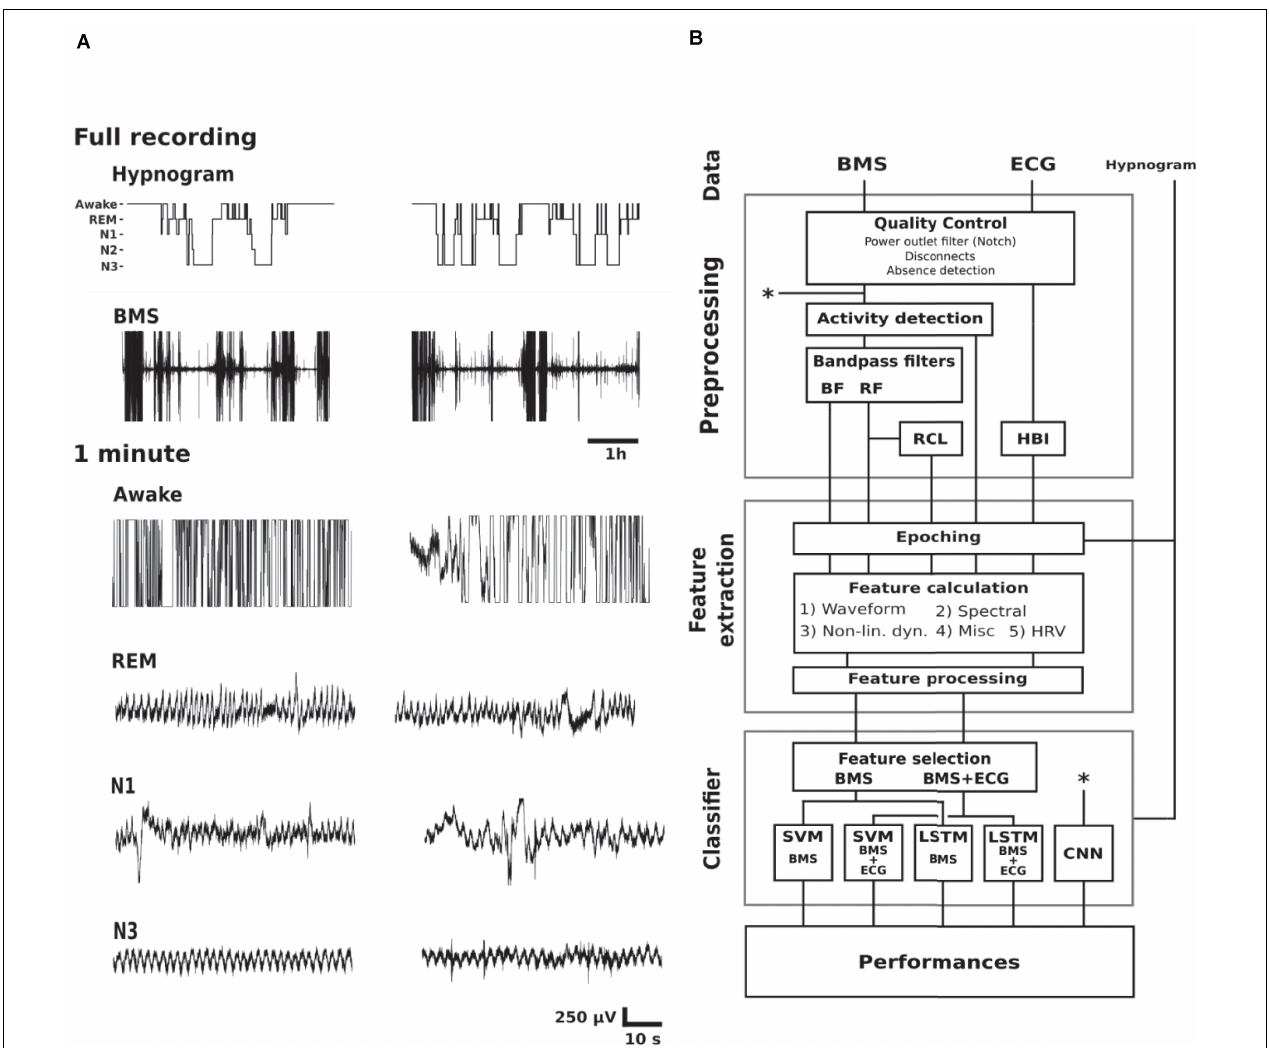
FIGURE 1 | Study design. (A) Examples of hypnogram and BMS data of two subjects (columns) in different vigilance states. The BMS signals below the hypnograms show the full length of BMS signal where movement epochs are readily observed. The shorter 1 min epochs show examples of awake (lots of high amplitude artifacts), REM sleep (variable respiration frequency with relatively stable baseline), light sleep (N1; variable respiration frequency with baseline instability due to movements), as well as N3 (relatively stationary respiration, i.e., steady respiration frequency and amplitude). (B) A schematic diagram of classifier construction divided into functional blocks. Abbreviations: Rapid eye movement (REM), non-REM 1–3 (N1–3), bed mattress sensor (BMS), ballistocardiographic bandpass filtered BMS (BF), respiration frequency bandpass filtered BMS (RF), respiration cycle length series (RCL), heart beat interval series (HBI), non-linear dynamics feature category (Non-lin. dyn.), heart rate variability (HRV), support vector machine (SVM), Long Short-Term Memory neural network (LSTM), convolutional neural network (CNN). Asterisks refer to the shortcut of the CNN pipeline from the raw signal (upper asterisk) to the classifier training (lower